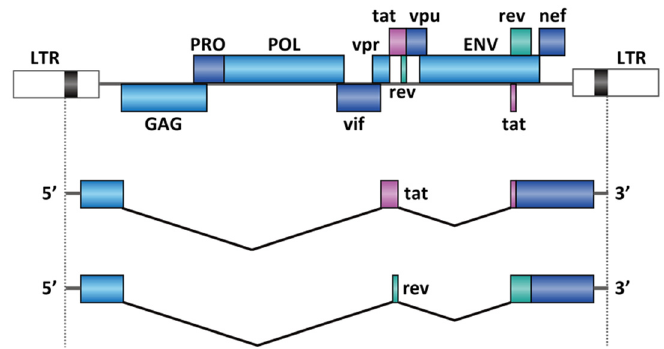
Figure 7. RNA splicing in HIV-1 genes tat and rev. The figure represents only two sets of the potential splice sites out of four alternative 5 ′ splice sites and eight alternative 3 ′ splice sites [125]. The figure is modified from ViralZone, SIB Swiss Institute of Bioinformatics. Table 3. Selected human pathogenic viruses with essential RNA splicing processes.